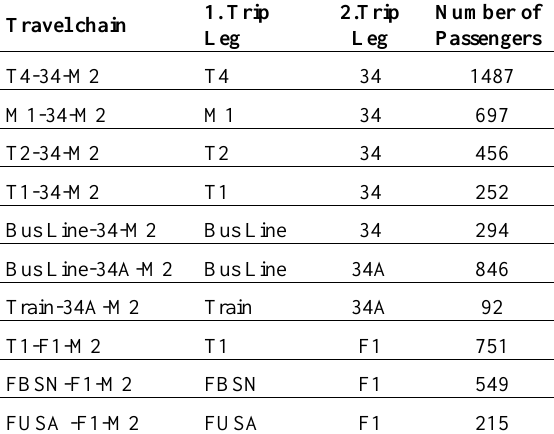
Table 6. Hourly number of passengers interchanging to subway line M2 with minimum two interchanges on the listed